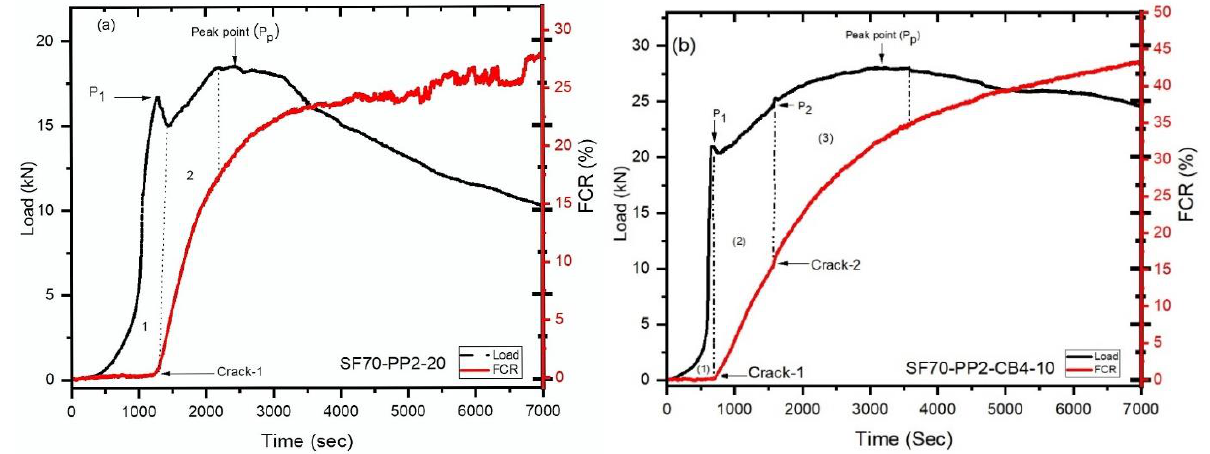
Figure 8. Load-time-FCR curves of ( a ) SF70-PP2-20 ( b ) SF70-PP2-CB4-10.